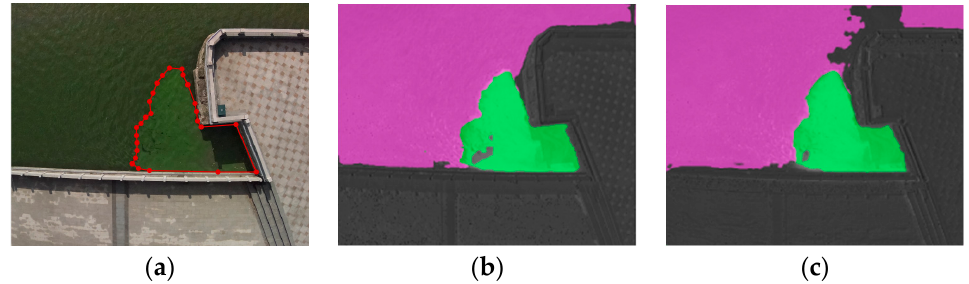
Figure 4. Detection results of different algorithms for regular scene: ( a ) visible light image; ( b ) de- tection results of NDVI as the feature-extraction method; ( c ) detection results of NDVI sqrt as the fea- ture-extraction method.